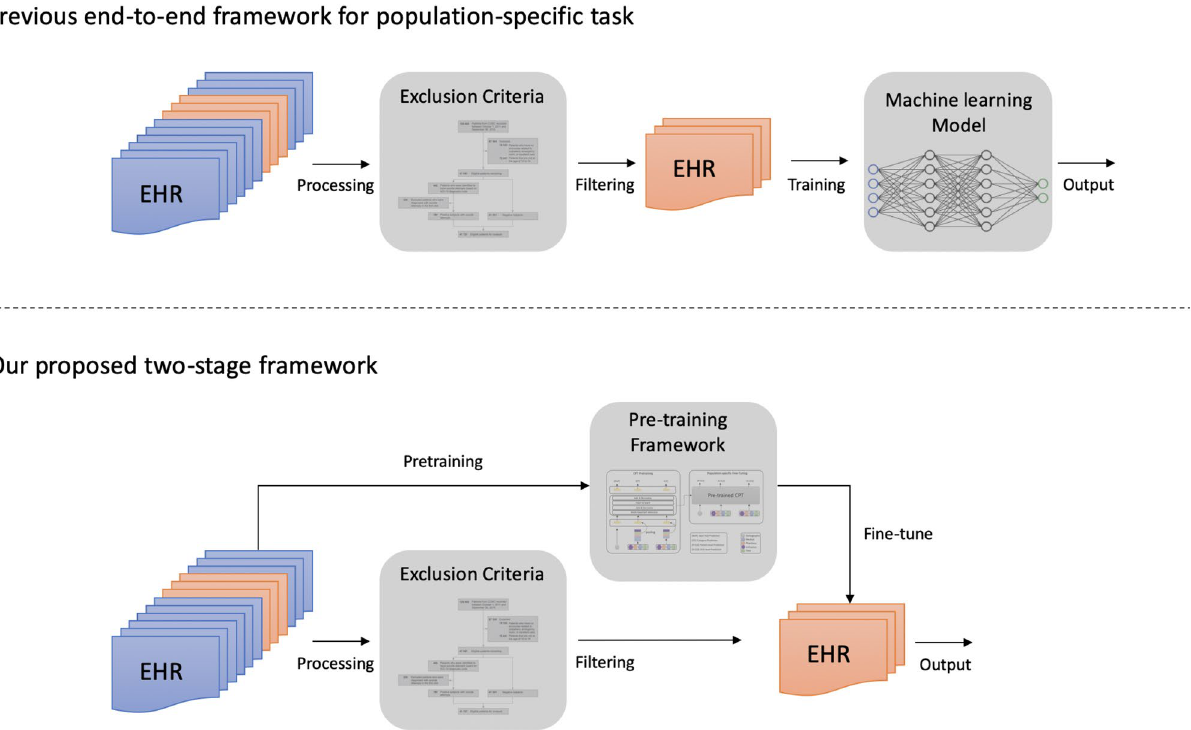
Figure 1. The motivation of our study. The traditional pipeline (top) of most medical predictive tasks requires rigorous criteria to construct the case and control patient cohort, undermining deep learning models’ predictive power and leading to suboptimal performance. Our proposed pre-training and fine-tuning framework (bottom) leverage the excluded patient records and significantly boost the model